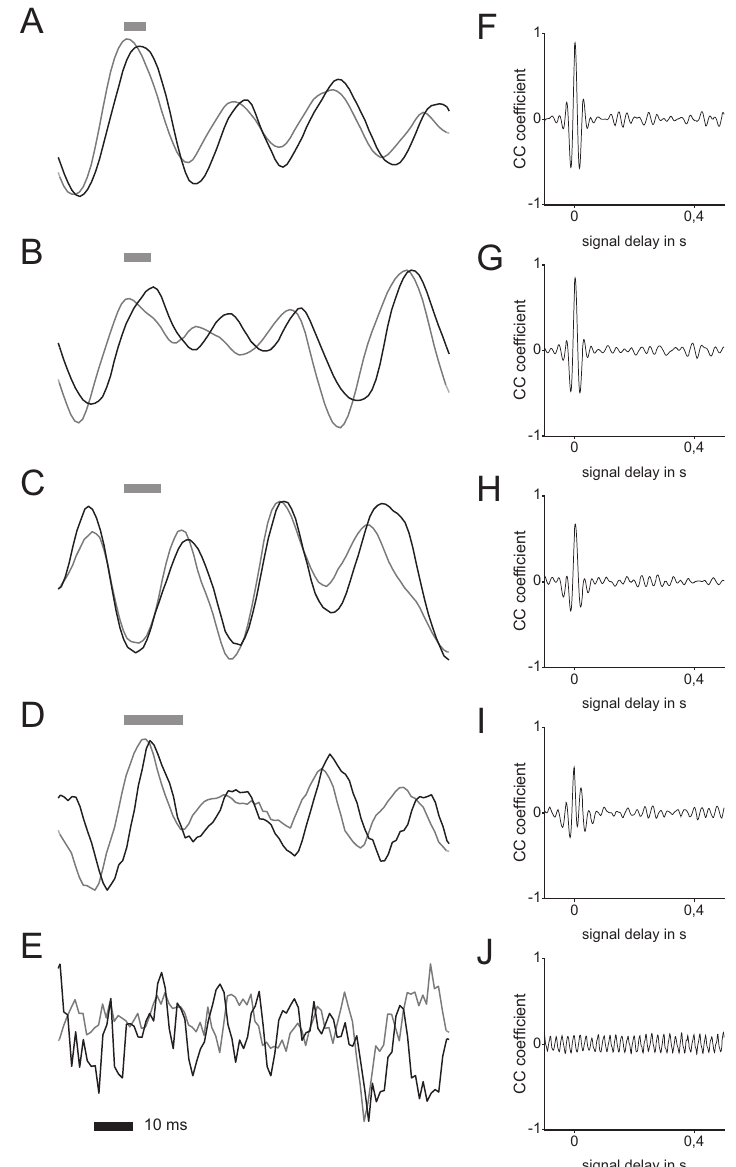
Figure 5. Original signals and cross-correlation functions of the proof of principle study. ( A – E ) Signals of the adjacent Sensors S6 (gray line) and S7 (black line). Flow rate 797 L/h ( A ), 672 L/h ( B ), 485 L/h ( C ) 308 L/h ( D ) and 0 L/h (no flow condition) ( E ). Gray bars indicate expected temporal delay between waveforms. Amplitudes are normalized and not to scale. ( F – J ) The cross-correlation functions of the two sensor signals shown in ( A ) to ( E ) for a time interval of 10 s. The bulk flow rates estimated from the cross-correlation of adjacent sensor signals (e.g., S4 and S5 or S6 and S7) did not vary over the range of flow rates applied (unfilled circles in Figure 6). In contrast, the flow rates estimated from the cross-correlations of the signals of sensors spaced 10 or 15 mm apart scaled with the reference flow rates applied, even though the sensor array overestimated the real flow rates. When excluding estimated flow rates from adjacent sensors and exceeding the range of 0 to 2000 L/h, the transfer function revealed a linear relation for reference flow rates ranging from 400 to 800 L/h ( y = 1 . 94 x − 329 . 9 ; R 2 = 0 . 76)